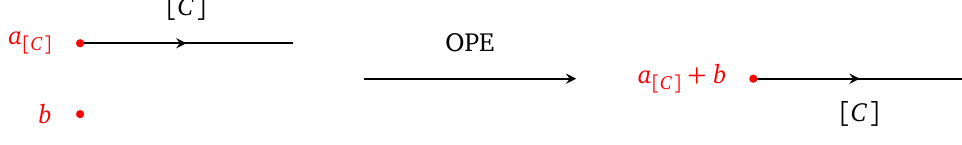
Figure 5: Taking OPE of a genuine local operator with a local operator living at the end of a line defect leads to another local operator living at the end of that line defect. The flavor center charges are added in this